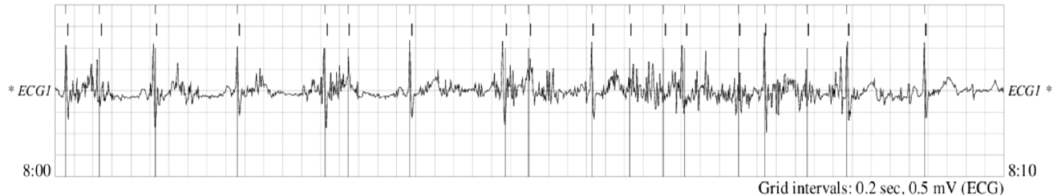
Figure 6. Occurrence of the signal noted as an “isolated QRS-like artefact” in record #16272 [12,13,15].